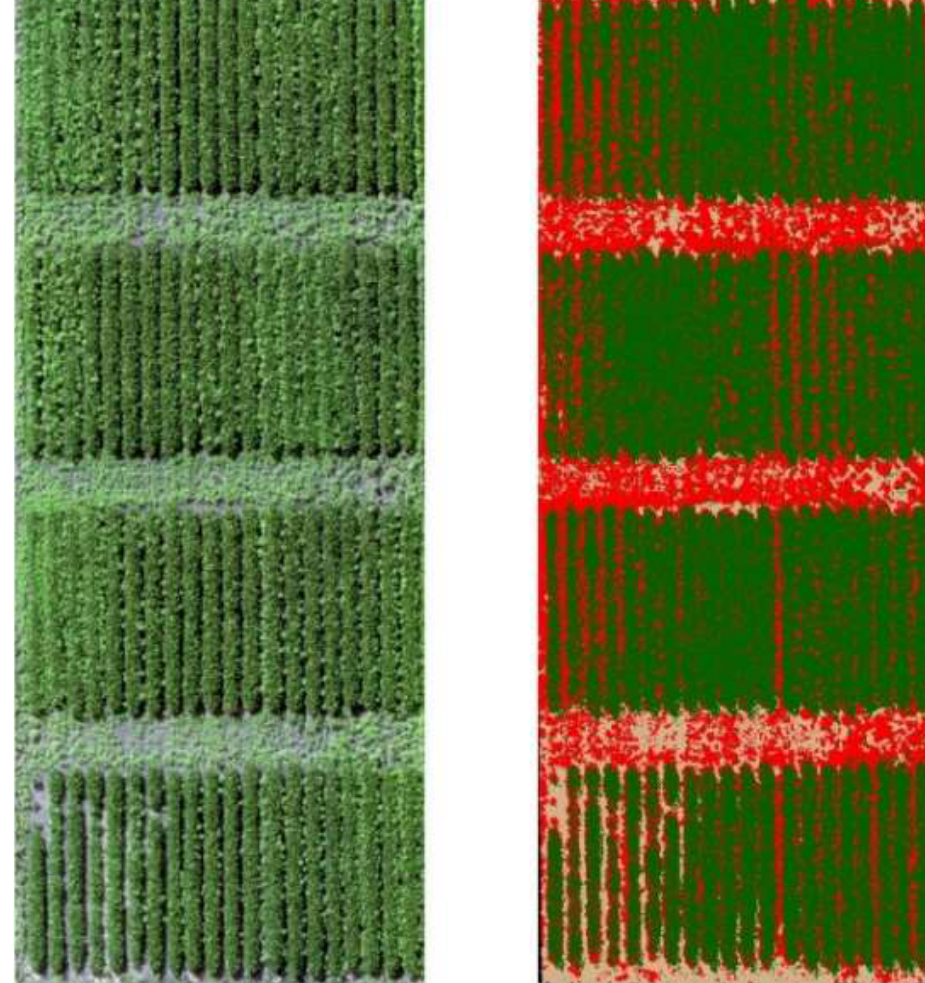
Figure 1. Comparison of a raw ( left ) and two-class classified image ( right ) of Palmer amaranth and soybeans growing in mixed stands. In the classified image, green represents soybean while red represents Palmer amaranth.